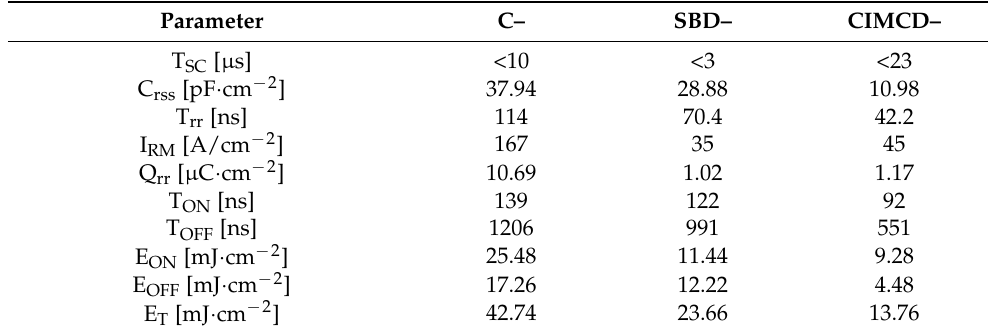
Figure 12. Comparison of the ( a ) power dissipation and ( b ) total switching energy loss of C–DMOSFET, SBD–MOSFET, and CIMCD–MOSFET that were obtained via the double pulsed test. Table 3. Dynamic characteristics of devices.